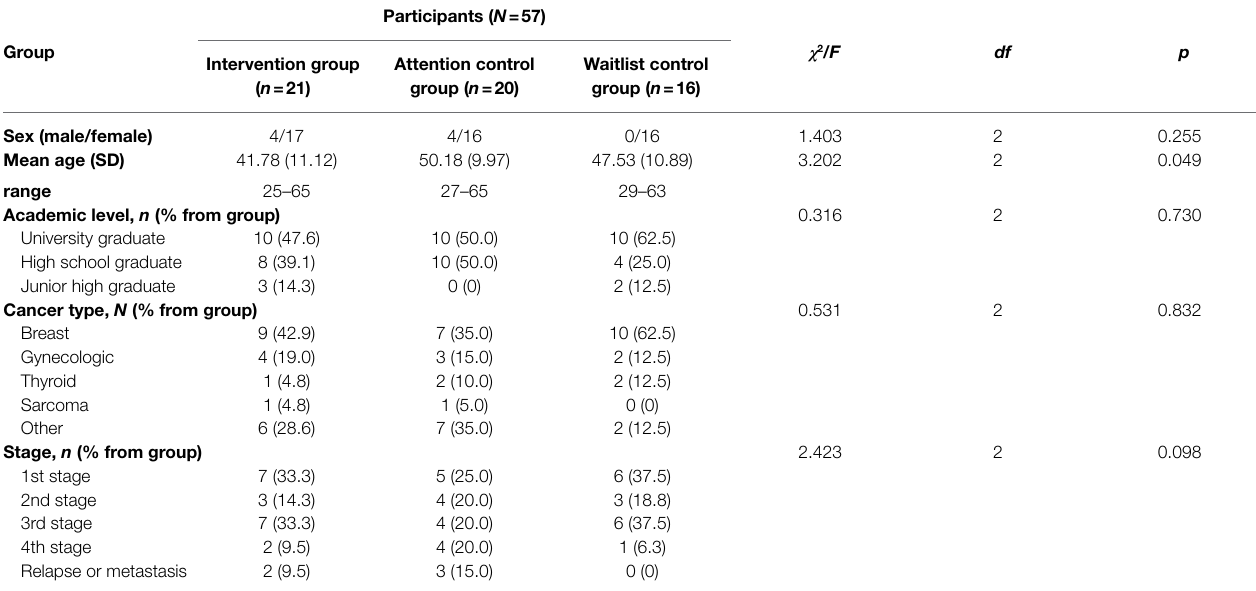
TABLE 1 | Participants’ demographics per group (all